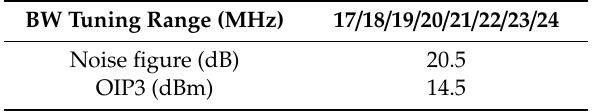
Table 6. Post simulated performance specifications of a third-order Butterworth LPF.